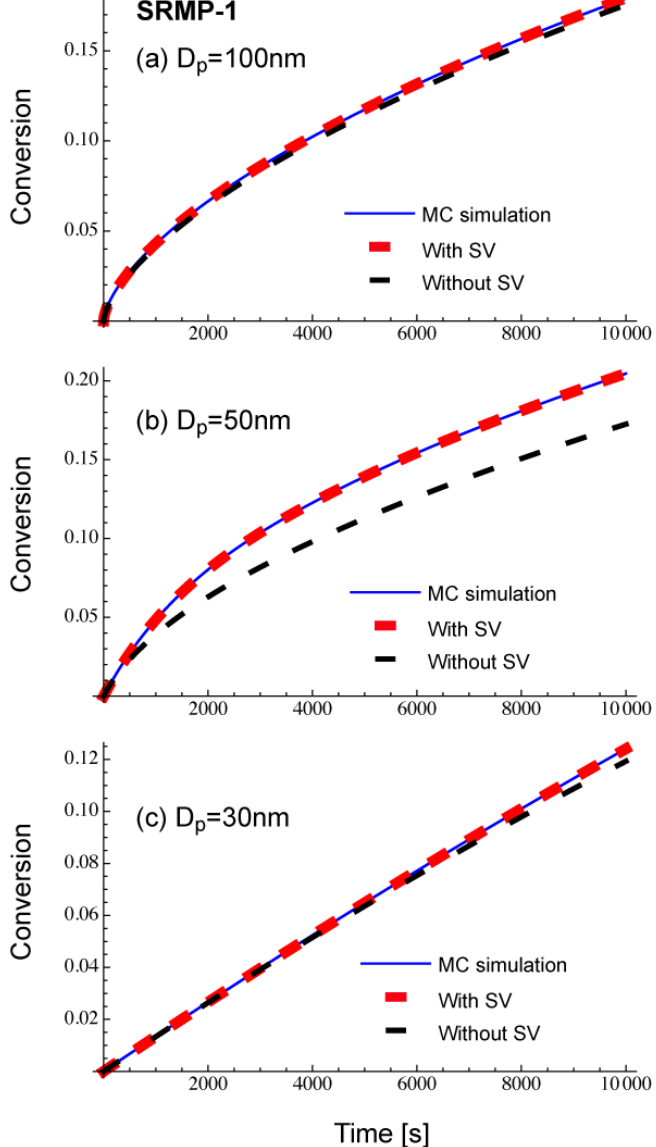
Figure 3. Calculated conversion development for a miniemulsion SRMP, whose parameters are described in the text, and are the same as SFRP-1 used in [13]. The blue line is obtained from the Monte Carlo simulation; the red symbols are calculated from Equation (11) that accounts for the statistical variation of concentrations among particles; and the black symbols are from Equation (12) that neglects the statistical